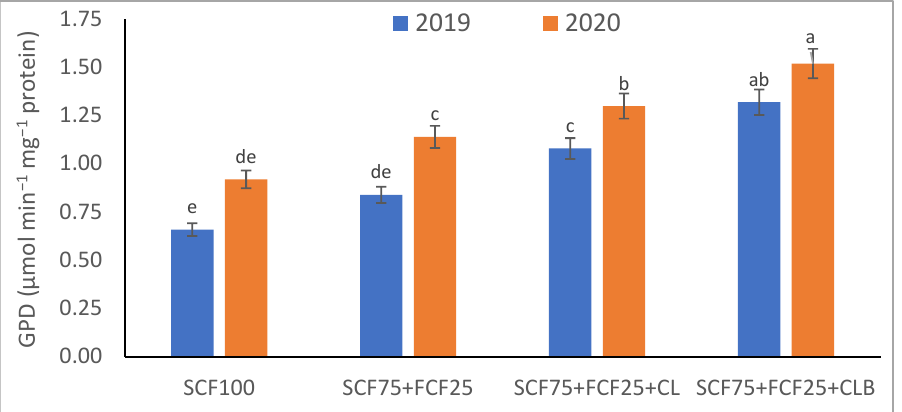
Figure 10. Response of leaf enzyme activity (catalase—CAT) of Phaseolus vulgaris plants to different fertilization strategies applied in two seasons (2019 and 2020) to sandy soil. Abbreviations of fertilization treatments are explained in Table 1. Bars with a different letter indicate significant difference between treatments at p ≤ 0.05.